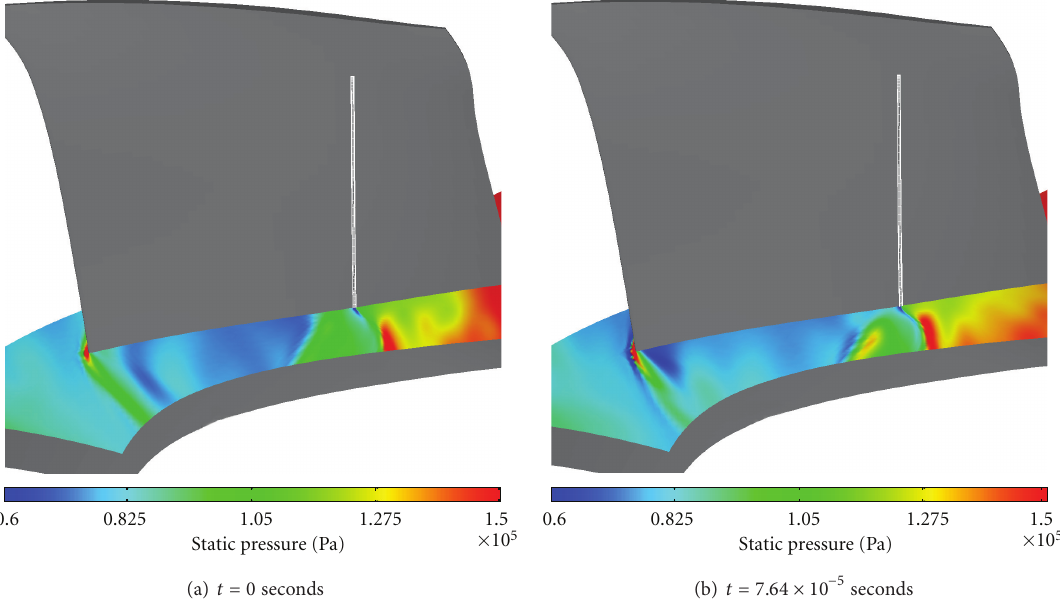
F 18: Instantaneous static pressure contours on a 10